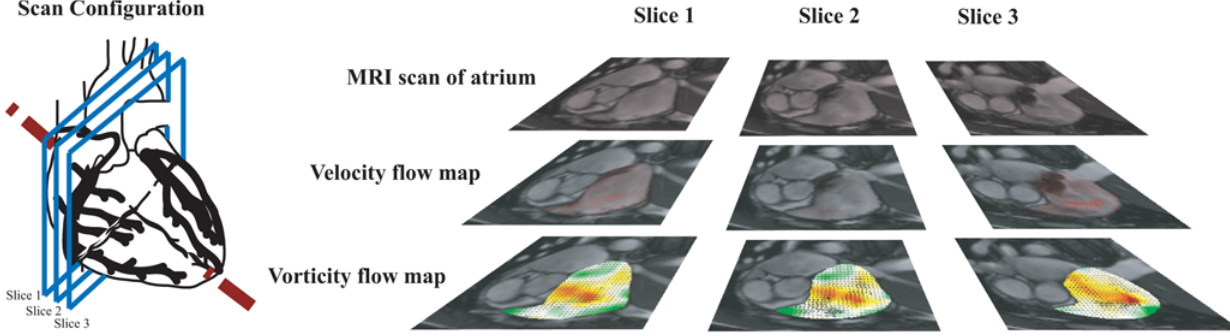
Figure 1. Imaging of heart based on short axis scan configuration. Steady-state free precession magnetic resonance image scans of the cardiac chambers were performed based on the short axis view at slice intervals of 6 mm, and labeled as Slices 1, 2 and 3 starting from the top to apex of the heart. Velocity and vorticity maps can be determined from the MR motion flow field for every slice and time frame.